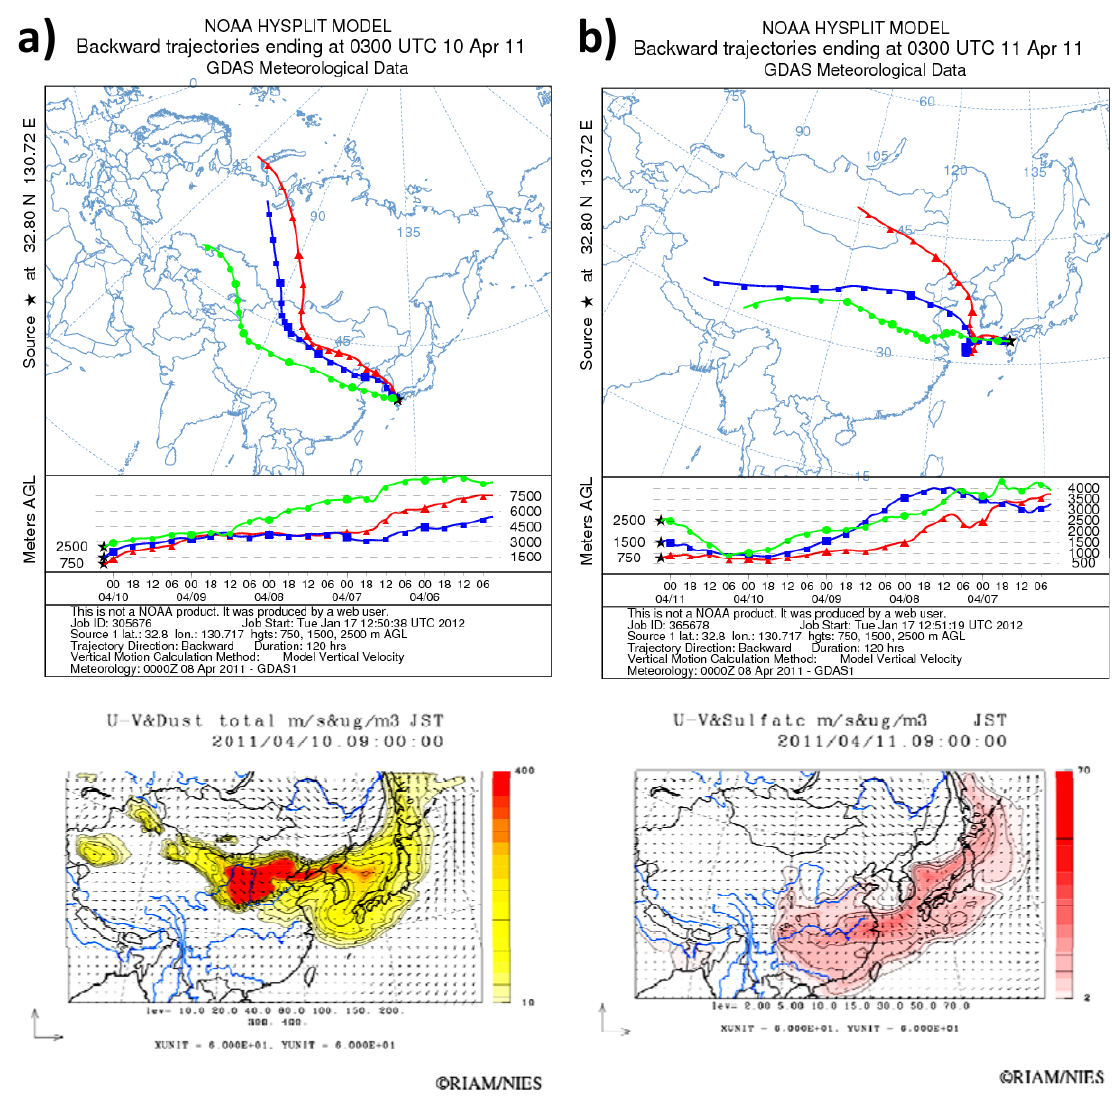
Fig. 3. Examples of HYSPLIT backtrajectories (top) and CFORS maps (bottom) illustrating the arrival of air masses from the Gobi Desert ( a – 10 April 2011) and Asia mainland ( b – 11 April 2011) resulting in a dust (a) and a sulphate (b) event in Kumamoto.